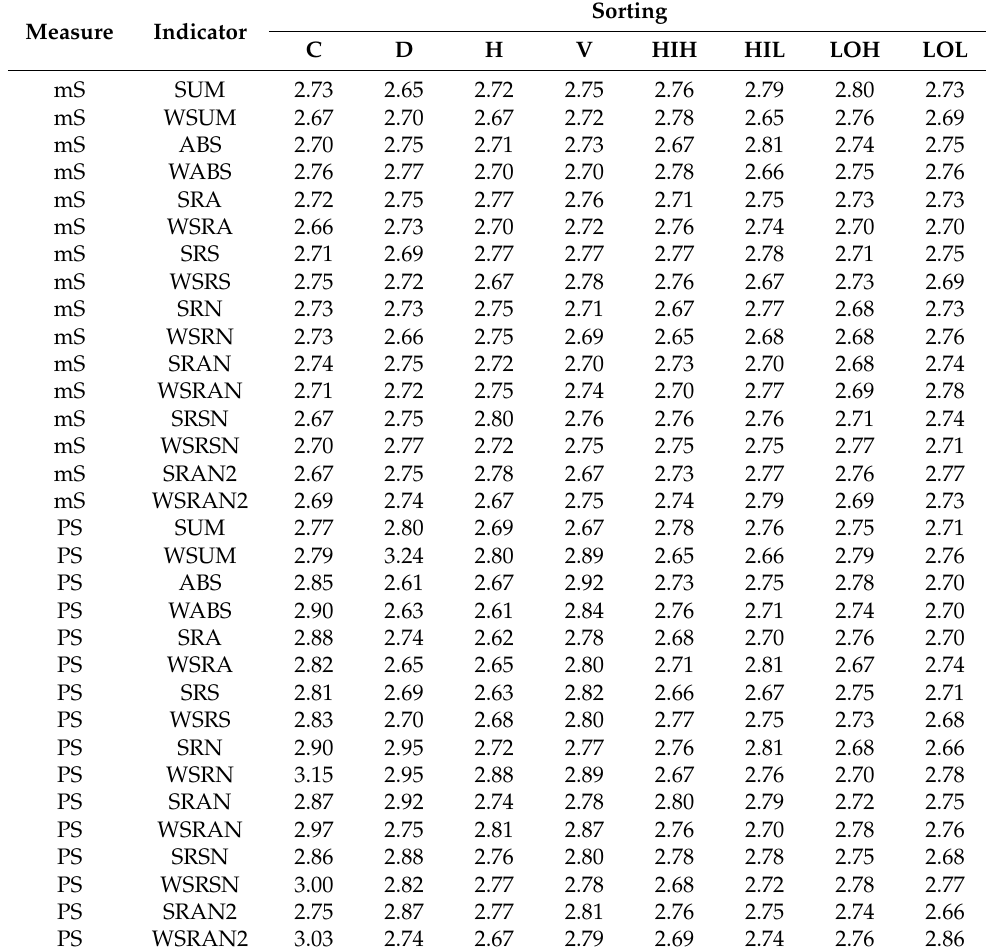
Table 9. Computational results for the NEH algorithm: ARPD values II.